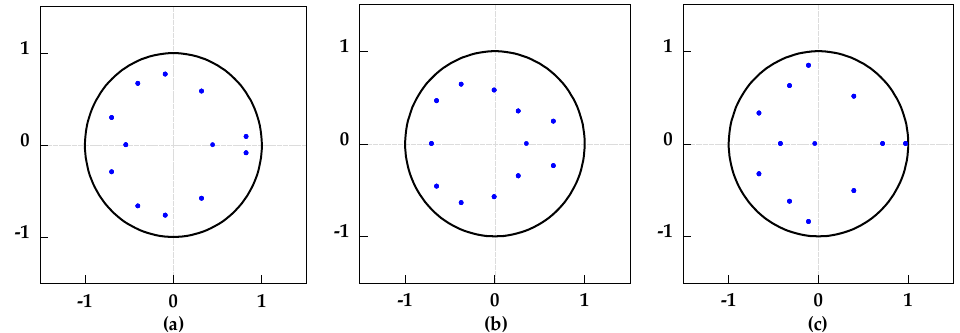
Figure 2. The results of stability test for the vector auto − regressive (VAR) (2) models. ( a ) The inverse roots of AR characteristic polynomial of the VAR (2) model A1. ( b ) The inverse roots of AR characteristic polynomial of the VAR (2) model A2. ( c ) The inverse roots of AR characteristic polynomial of the VAR (2) model